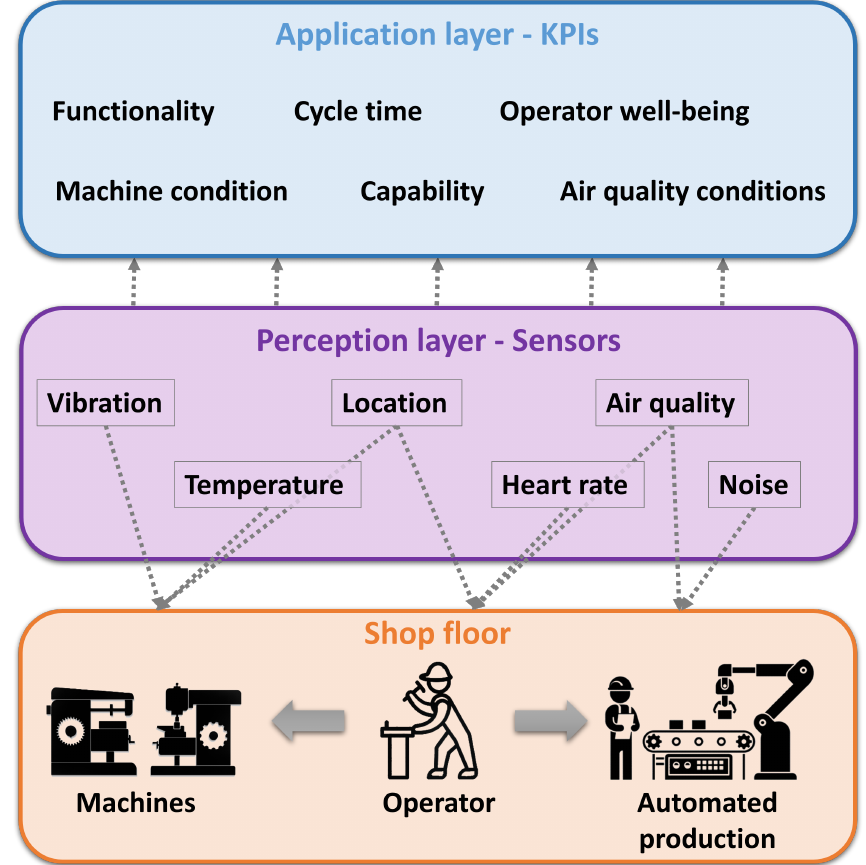
Figure 5. Determining the KPIs of the production